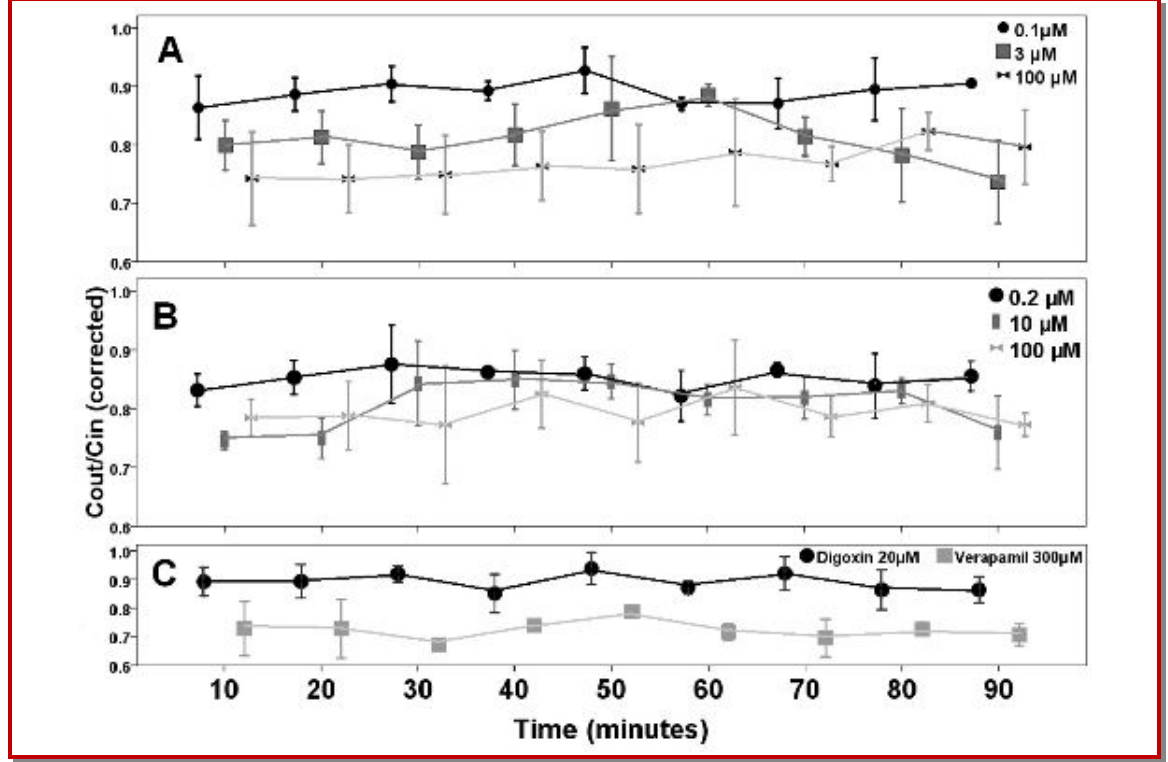
Figure 1: Plots of outlet and inlet concentrations ratio (Cout/Cin) of digoxin (20 µM) vs time for atorvastatin (A), ezetimibe (B), digoxin, and verapamil (C) in rat SPIP study (n = 3, error bars represent mean ±